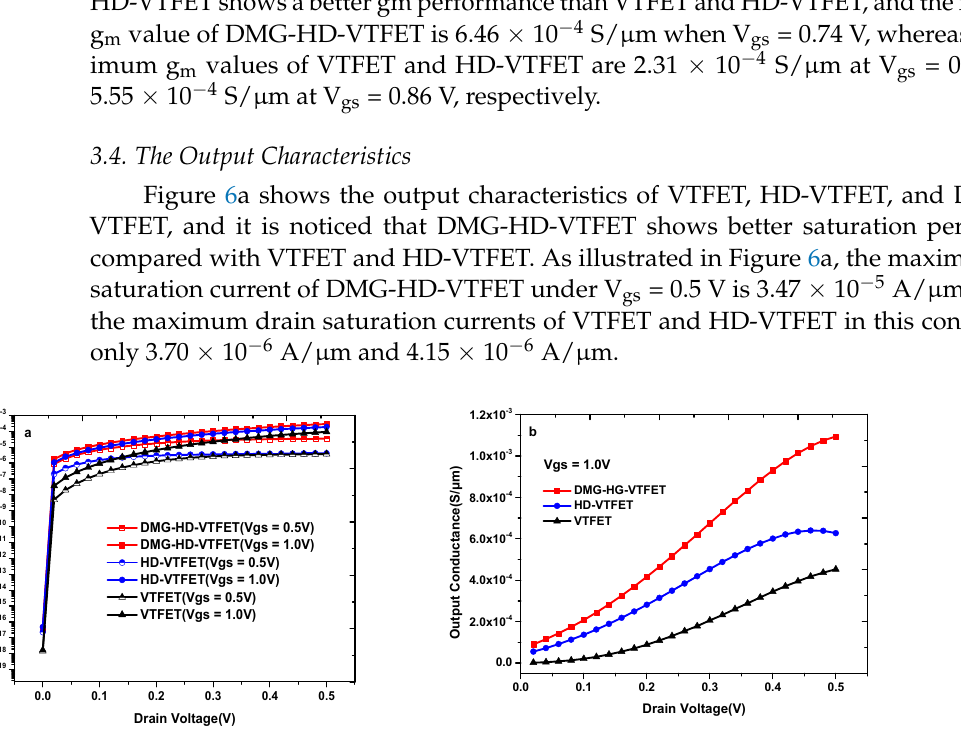
Figure 6. ( a ) Output characteristics of VTFET, HD-VTFET and DMG-HD-VTFET; ( b ) output transconductance of VTFET, HD-VTFET, and DMG-HD-VTFET at Vgs = 1 V.